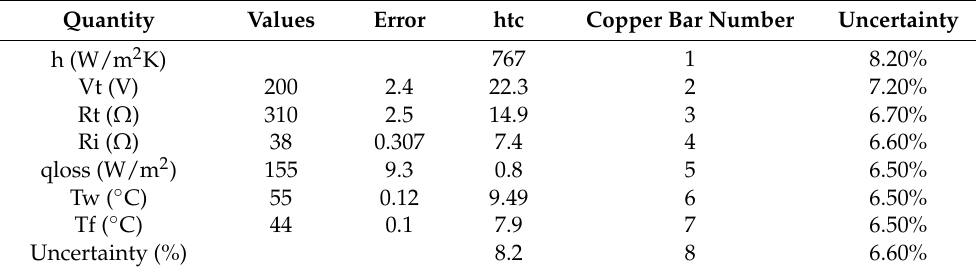
Table 2. Experimental uncertainty magnitudes for the heat transfer coefficient and associated quanti- ties to determine the heat transfer coefficient.